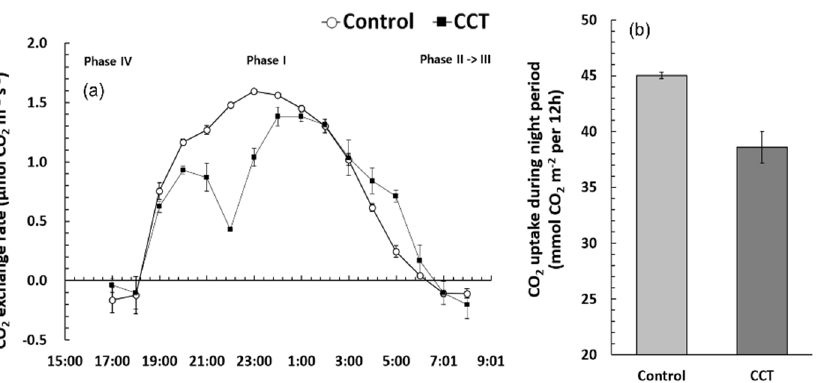
Figure 2. Changes of CO 2 exchange rate ( a ) and CO 2 uptake during night period ( b ) of Sedirea japonica under control (CO 2 = 400 ppm) and CCT (climate change treatment, CO 2 = 650 ppm, temperature = control + 3 °C) conditions. Each value is expressed as the mean ± SD ( n = 3).